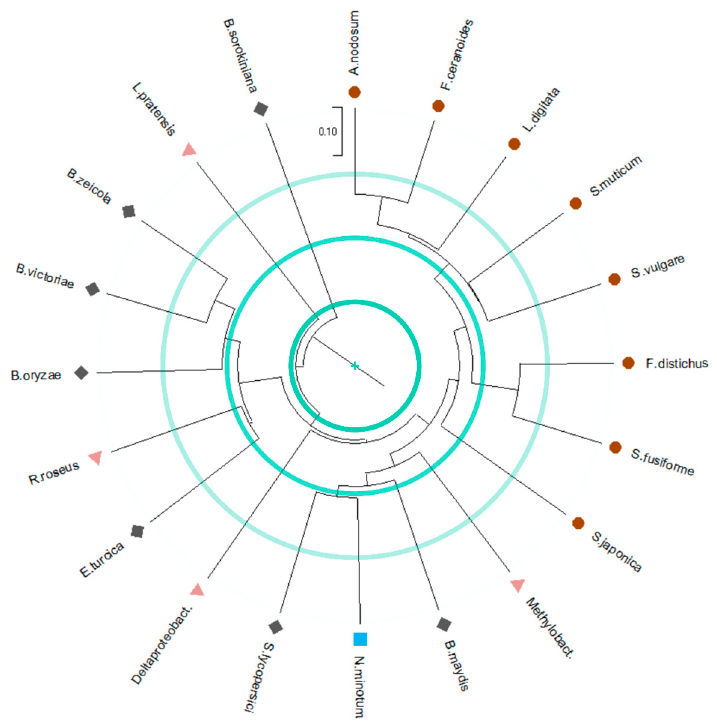
Figure 4. Clustering of the molecular recognition properties of the selected haloperoxidase structural models. Hierarchical clustering was performed for 20 haloperoxidase binding sites. The binding sites were encoded as DrugScore 2018 MIFs and compressed using Zernike descriptors. Manhattan distances between the Zernike descriptors were used for similarity assessment. The sequences are color-coded according to the taxonomy: algae in brown circles, bacteria in magenta triangles, cyanobacteria in cyan squares, and fungi in grey diamond shapes. The tree is drawn to scale with branch lengths in the same units as those of the distances used to infer the tree. Cyan concentric lines represent 25%, 50%, and 75% from the center of the maximum distance, respectively.